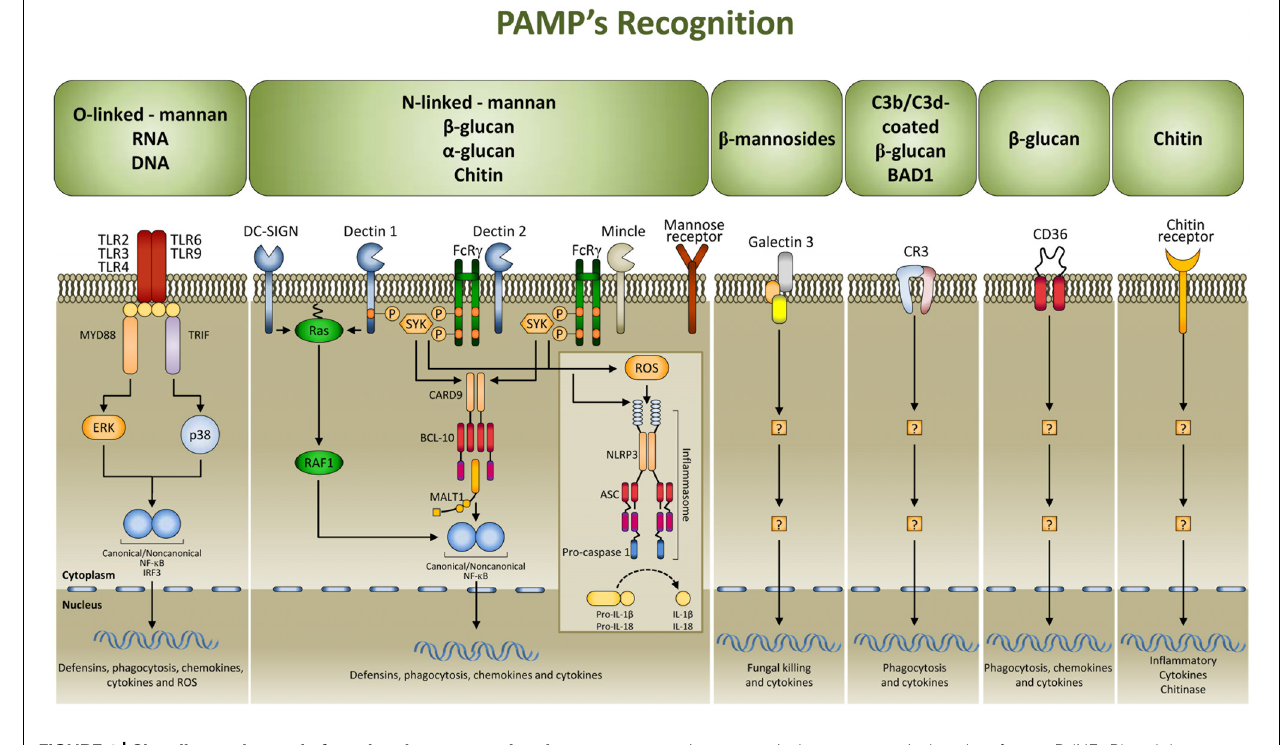
activate canonical or non-canonical nuclear factor- κ B (NF- κ B) and the NOD, LRR- and pyrin domain-containing 3 (NLRP3) inflammasome, and this culminates in the production of defensins, chemokines, cytokines, and reactive oxygen species (ROS). CR3, complement receptor 3; ASC, apoptosis-associated speck-like protein containing a CARD; BCL 10, B cell lymphoma 10; CARD9, caspase recruitment domain-containing protein 9; ERK, extracellular signal-regulated kinase; FcR γ , Fc receptor γ chain; IL, interleukin; IRF3, IFN-regulatory factor 3; MALT1, mucosa-associated lymphoid tissue lymphoma translocation protein 1; MYD88, myeloid differentiation primary response protein 88; SYK, spleen tyrosine